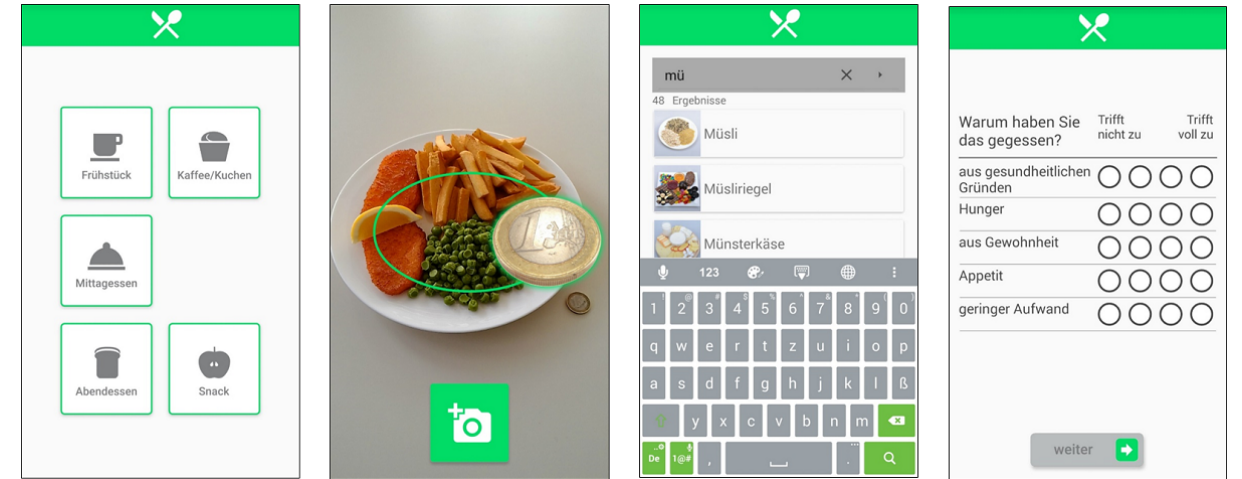
Figure 1. Screenshots of the SMARTFOOD app for assessing eating events and the 15 eating